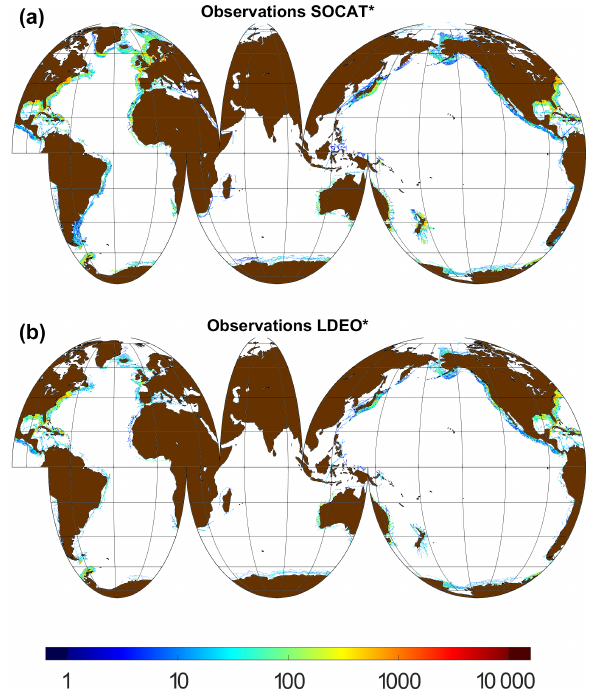
Figure 2. Number of observations contained in each 0.25 ◦ grid cell of the SOCAT ∗ (a) and LDEO ∗ (b)